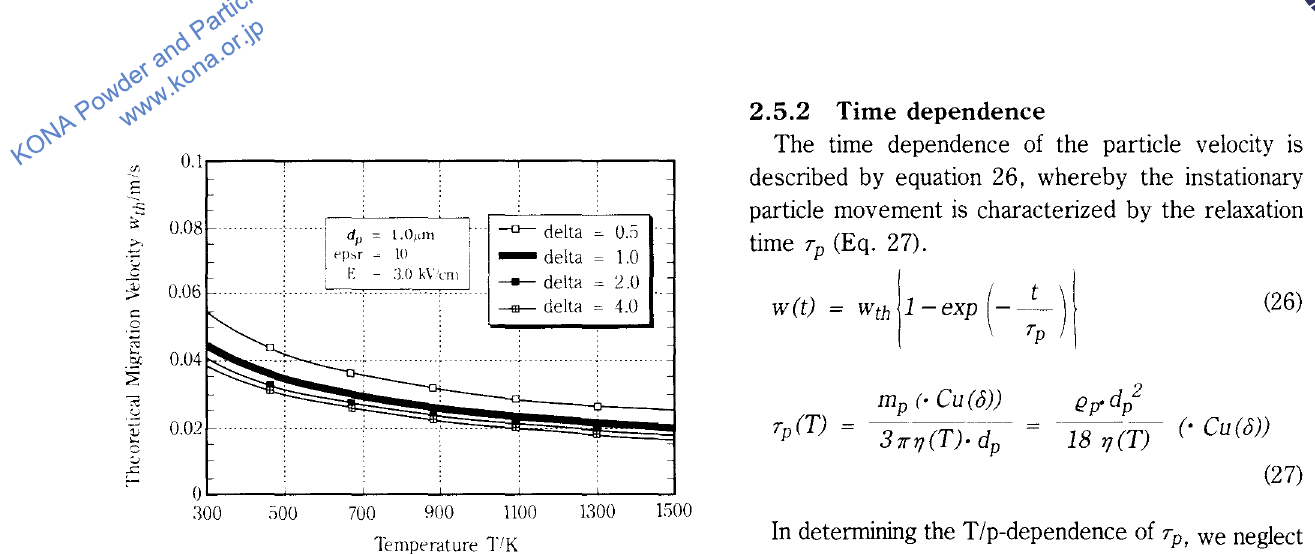
Fig. 12 Theoretical migration velocity of a 1.0 I'm particle